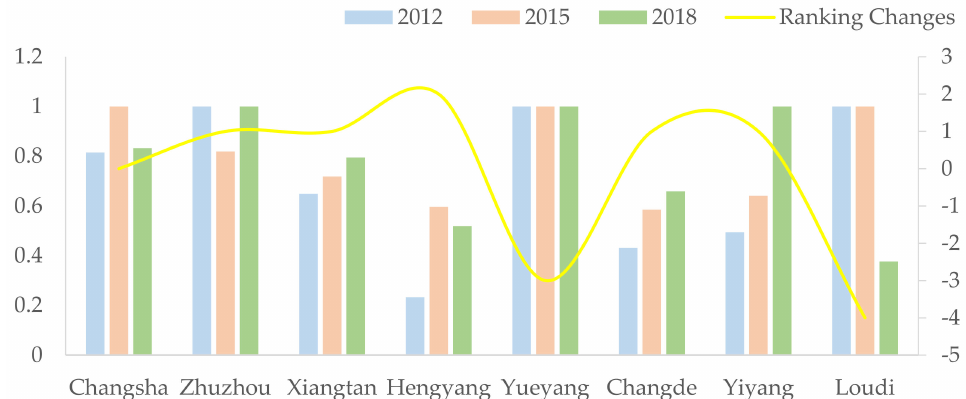
Figure 5. Trend of green innovation efficiency in the Great Changsha-Zhuzhou-Xiangtan City